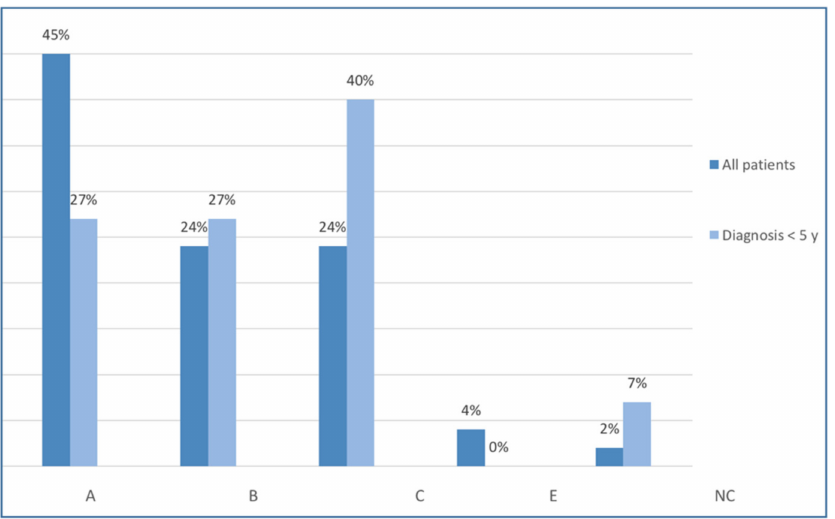
Figure 4. Distribution of clinical types according to Rigo Classification (A: Rigo type A; B: Rigo type B; C: Rigo Type C; E: Rigo Type E; NC: Not